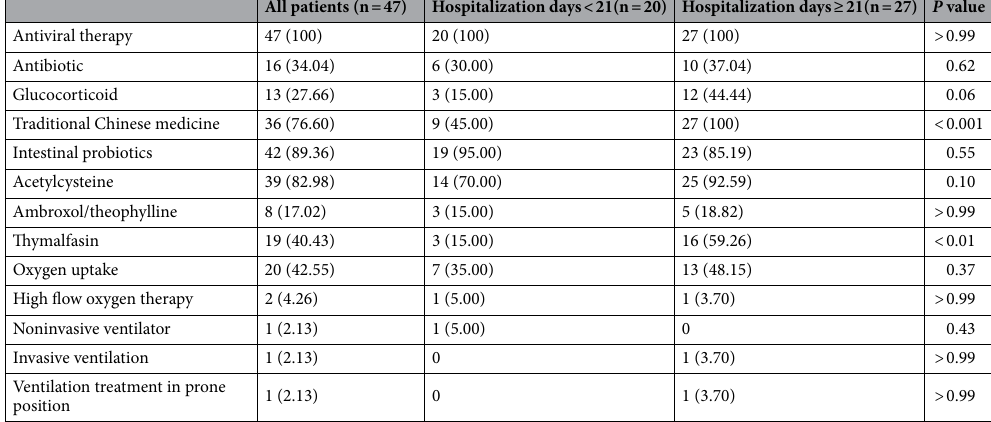
Table 3. Treatment of patients with COVID-19.